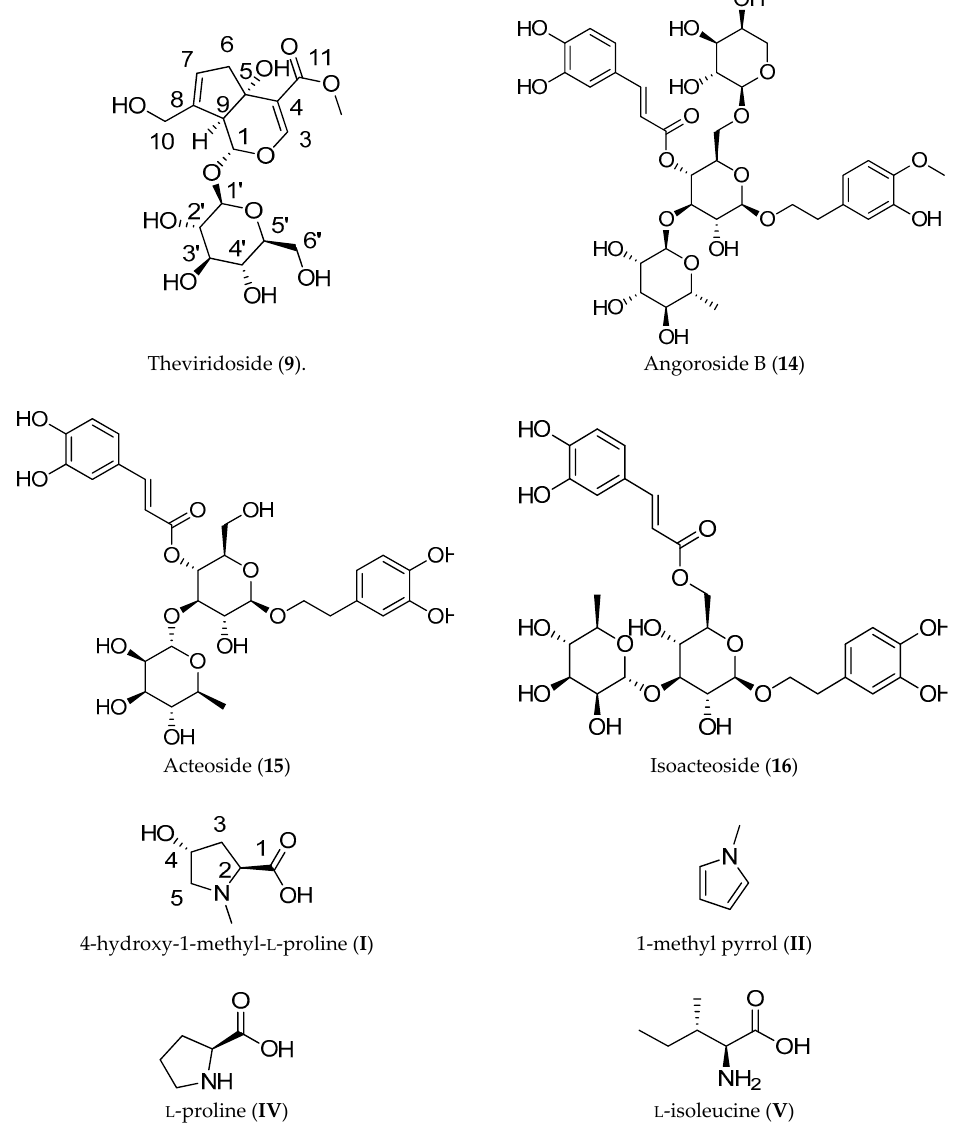
Figure 3. Structure of some of the main constituents of the Paraguayan crude drug ysypó hû